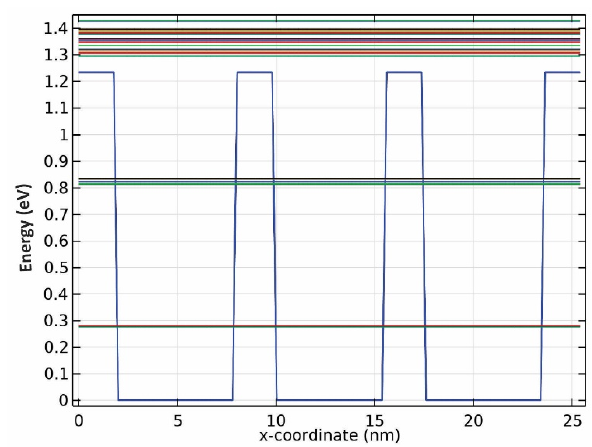
Figure 3. Energy band diagram for QDs with R1 radii.